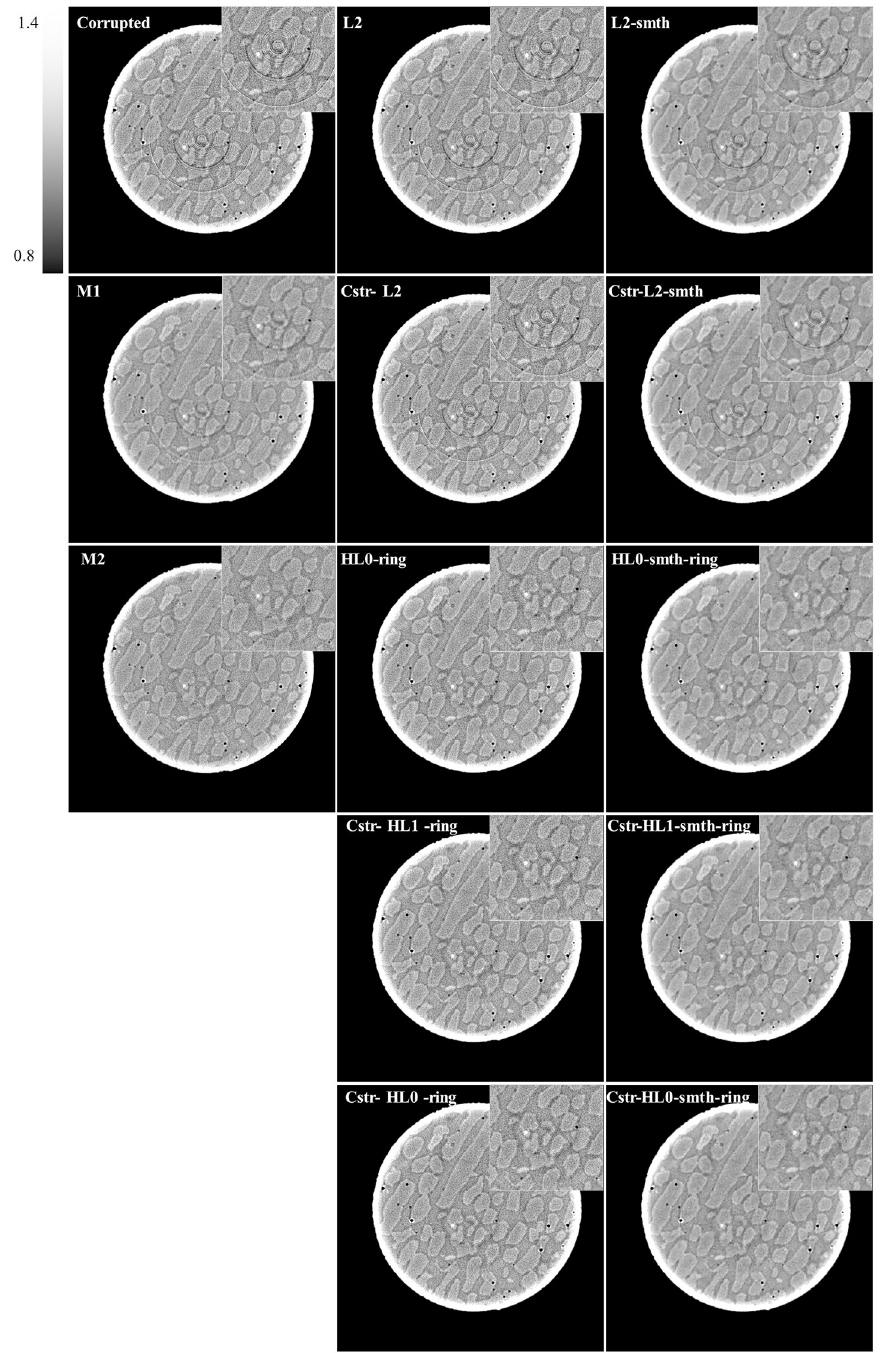
Fig 11. Results of the real